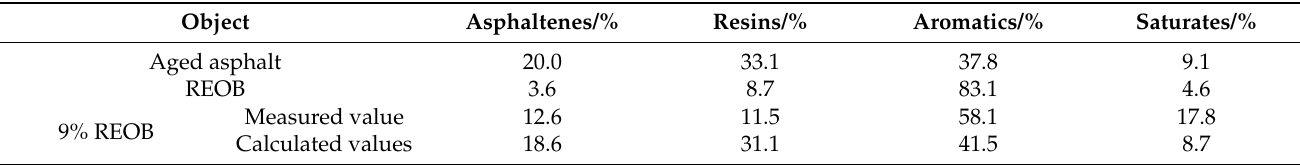
Table 8. Calculated results of the four components of 9%